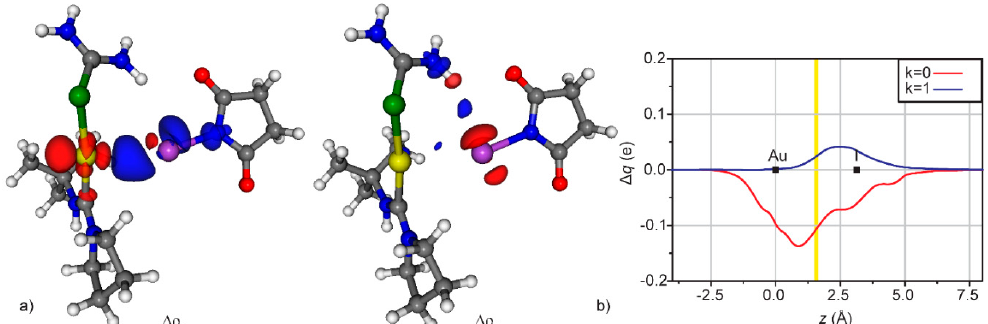
Figure 7. ( a ) Isodensity surfaces ( ± 1.2 me / bohr 3 ) for the deformation maps relative to the ∆ ρ k (k = 0 and 1) contributions of the [(SeU)Au(NAC)] + ... [NIS] bond. The charge flux is red → blue; ( b ) CD functions (CD k , k = 0 and 1) for the [(SeU)Au(NAC)] + ... [NIS] bond. Black dots indicate the z position of the atomic nuclei. A yellow vertical band indicates the boundary between the fragments. (Reproduced from Reference 37 with permission from the PCCP Owner